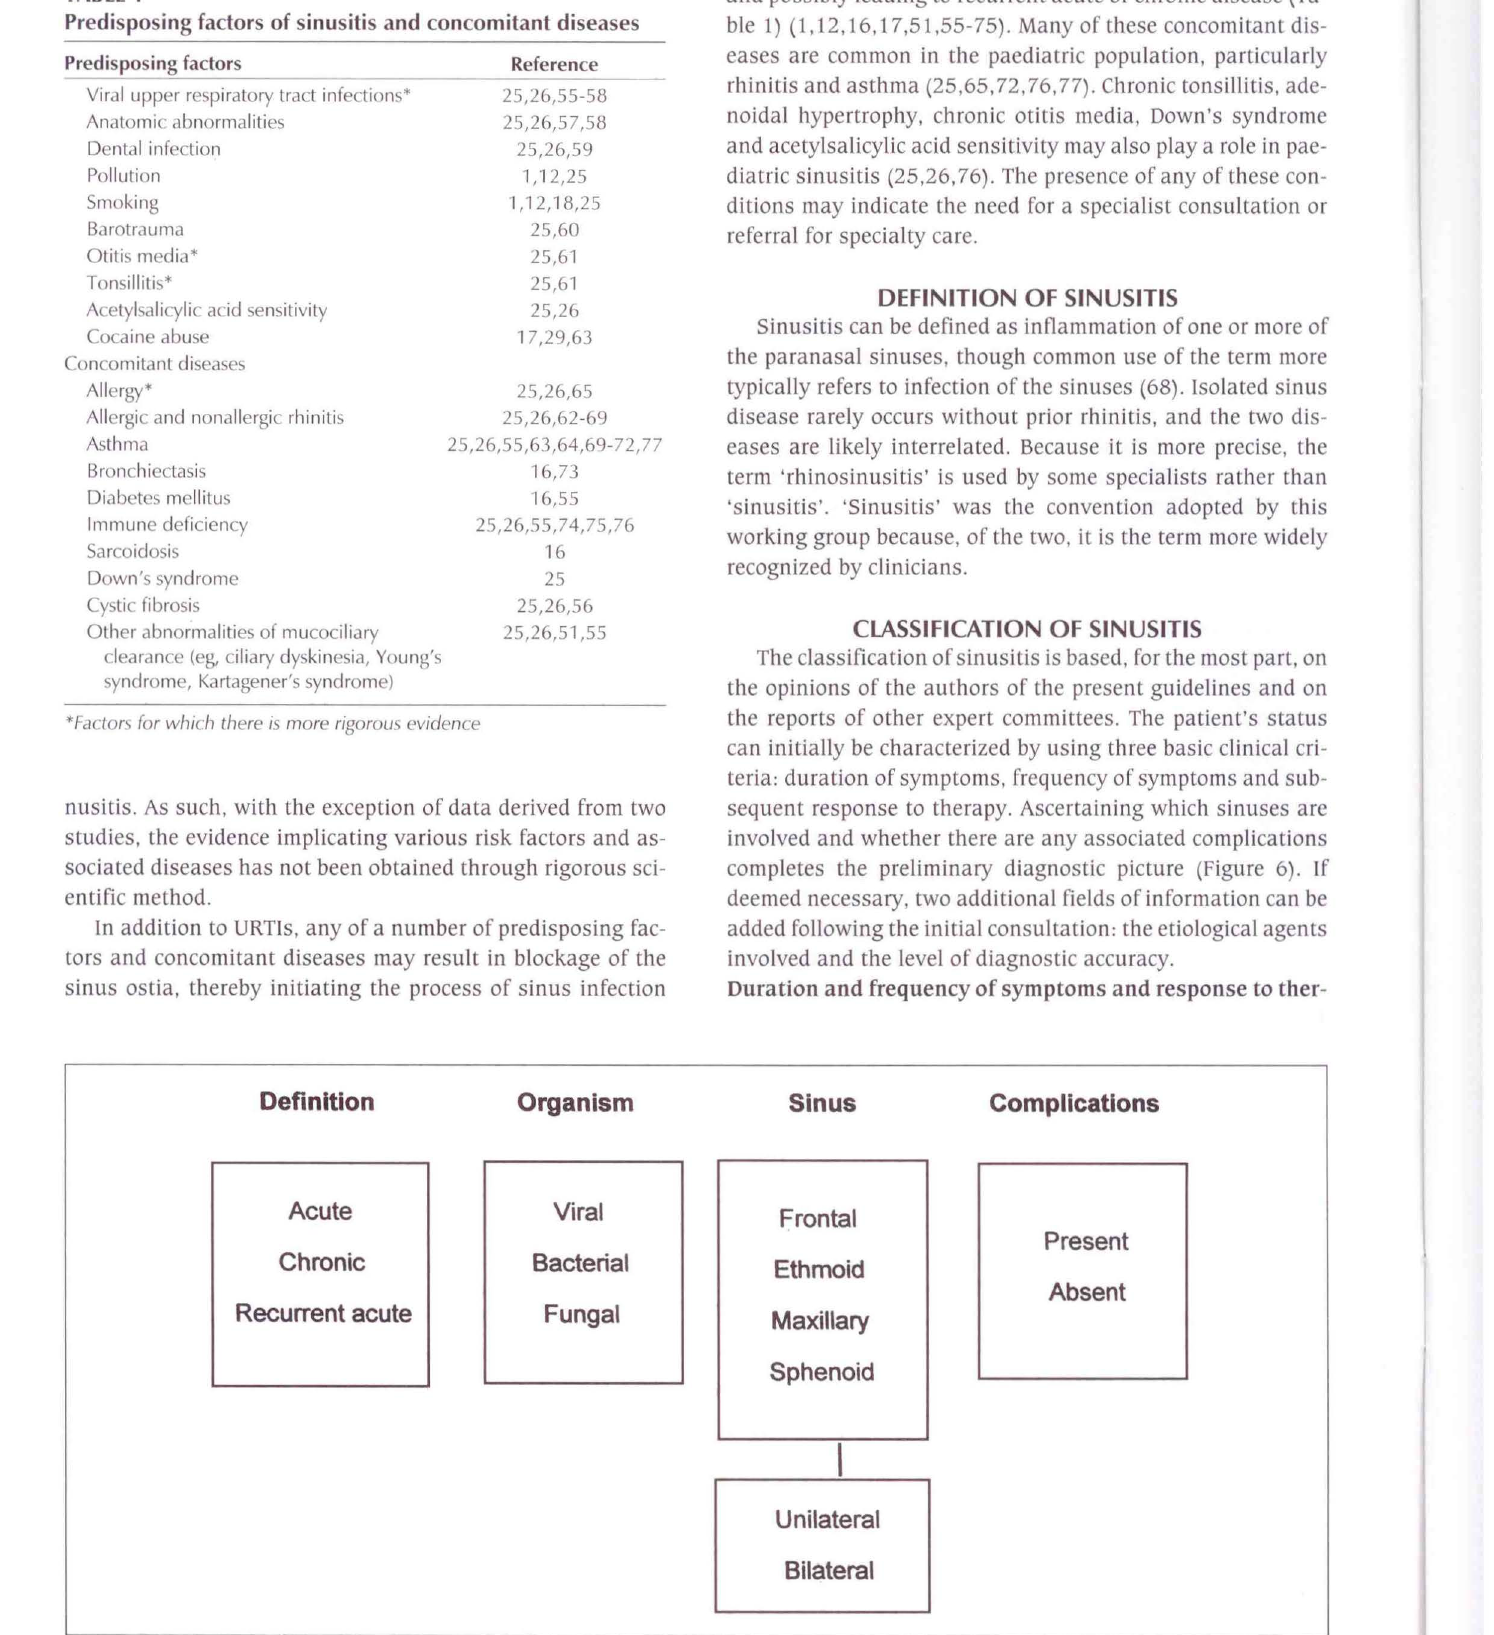
Figure 6) Sinusitis c/assjfication chart